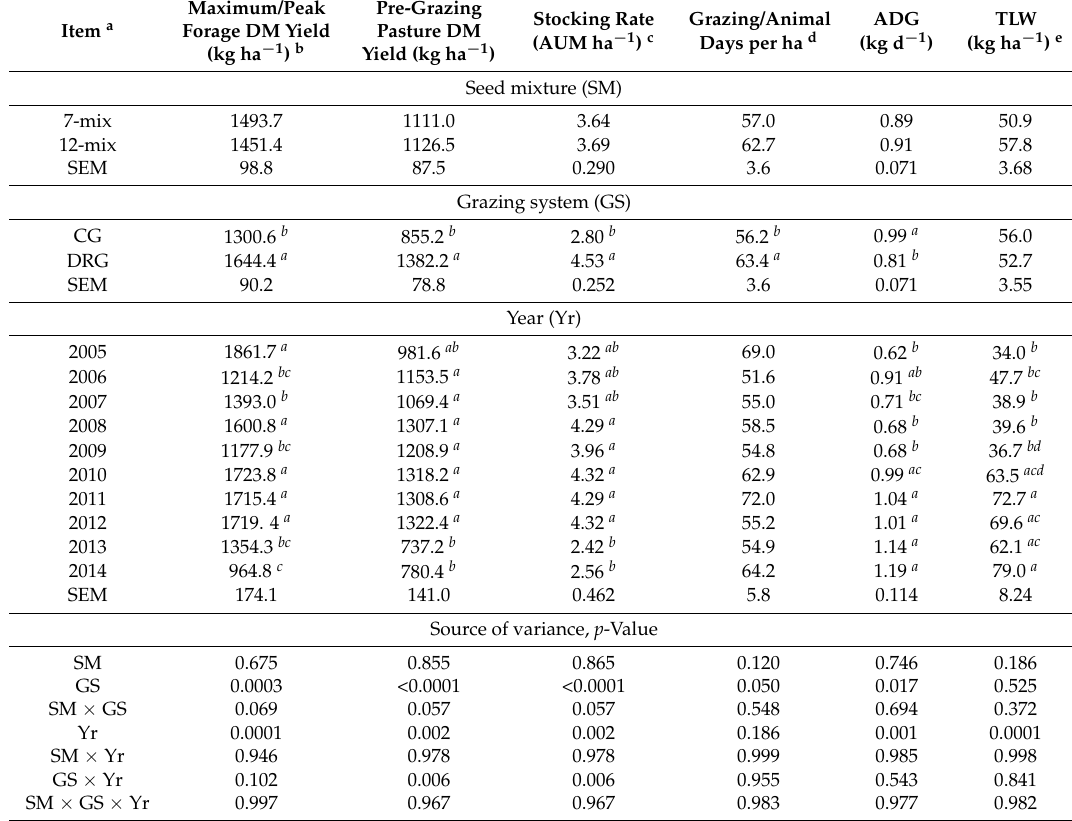
Table 3. The effect of seed mixture (7-mix, 12-mix), grazing system (continuous grazing (CG), deferred rotational grazing (DRG)) and production year (Yr) on pasture productivity and animal